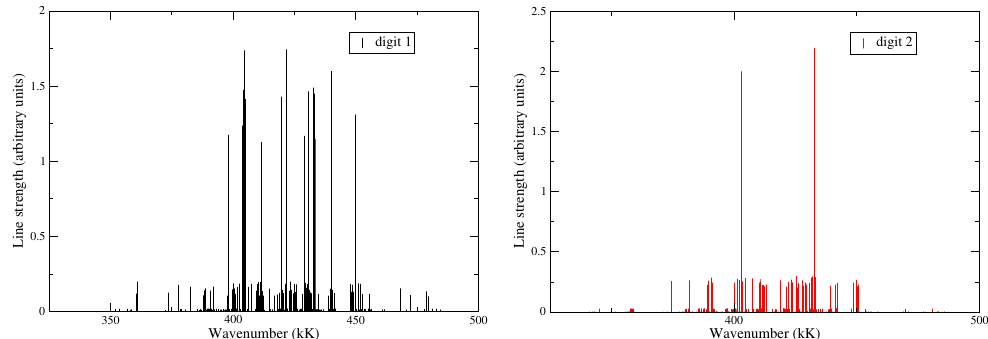
Figure 12. Number of lines with a first significant digit of 1 ( left ) and 2 ( right ) in their strength, as a function of their energy, for transition array 3 d 4